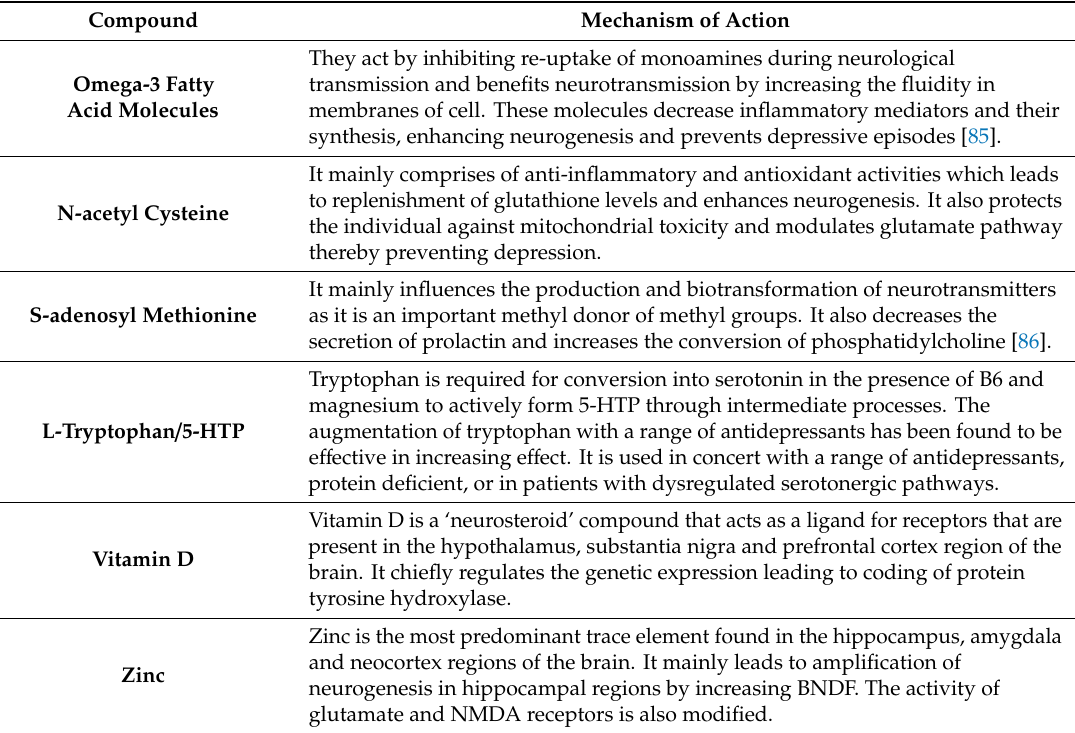
Table 1. Some of the commonly employed nutraceuticals in the management of depression as an adjunctive therapy, which thereby present a curative approach